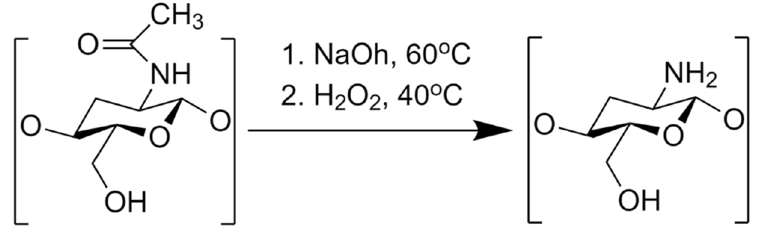
Figure 3. Synthesis of water-soluble chitosan (WSC).